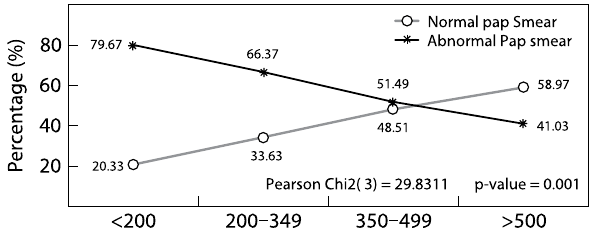
Figure 5: Association between CD4 cell count with abnormal Pap